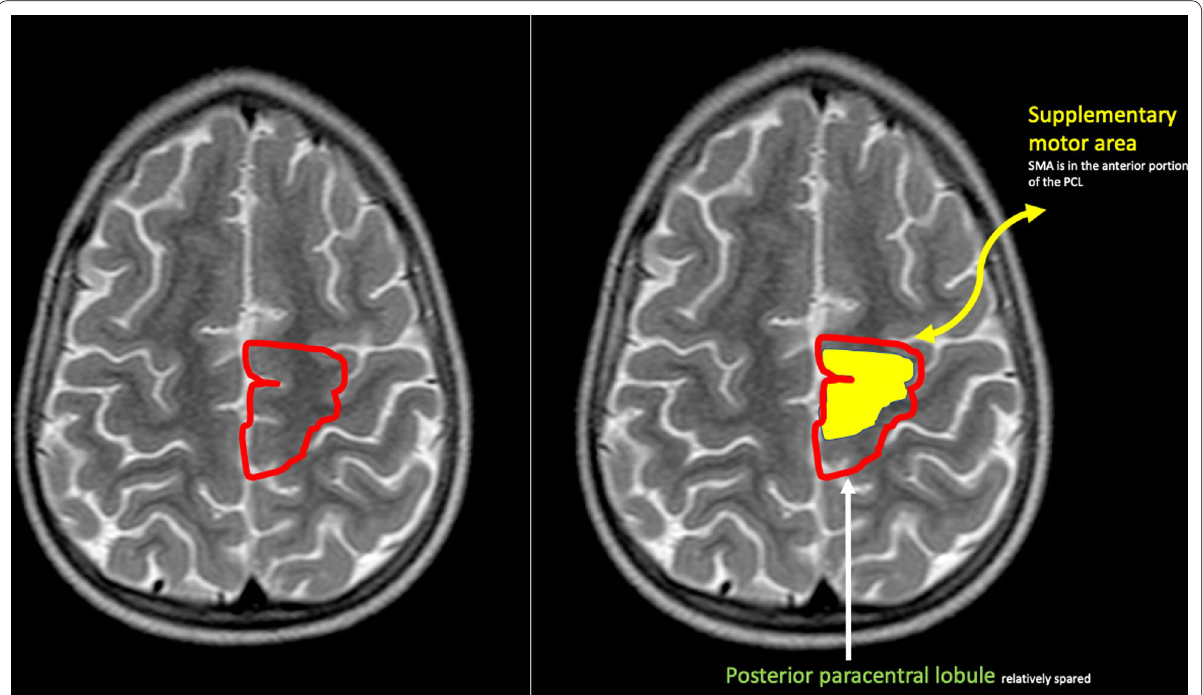
Fig. 8 The location of the paracentral lobule (PCL) with the anterior PCL connecting the supplementary motor area (SMA) to the precentral primary motor cortex and the posterior PCL connecting to the postcentral